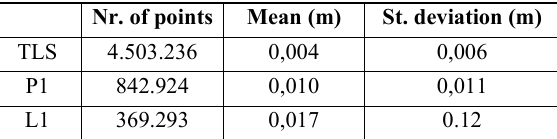
Figure 12. Geometric features computed for the P1 (on the left) and L1 (on the right) point clouds. Verticality (top, a), omnivariance (centre, b) and surface variation (bottom, c).